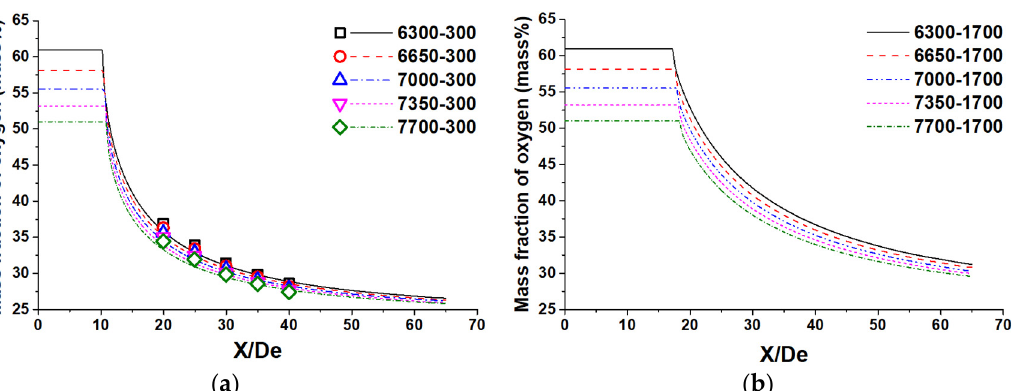
Figure 6. The oxygen distribution of the supersonic jet at the Laval nozzle centerline: ( a ) room ambient temperature; ( b ) high ambient temperature.